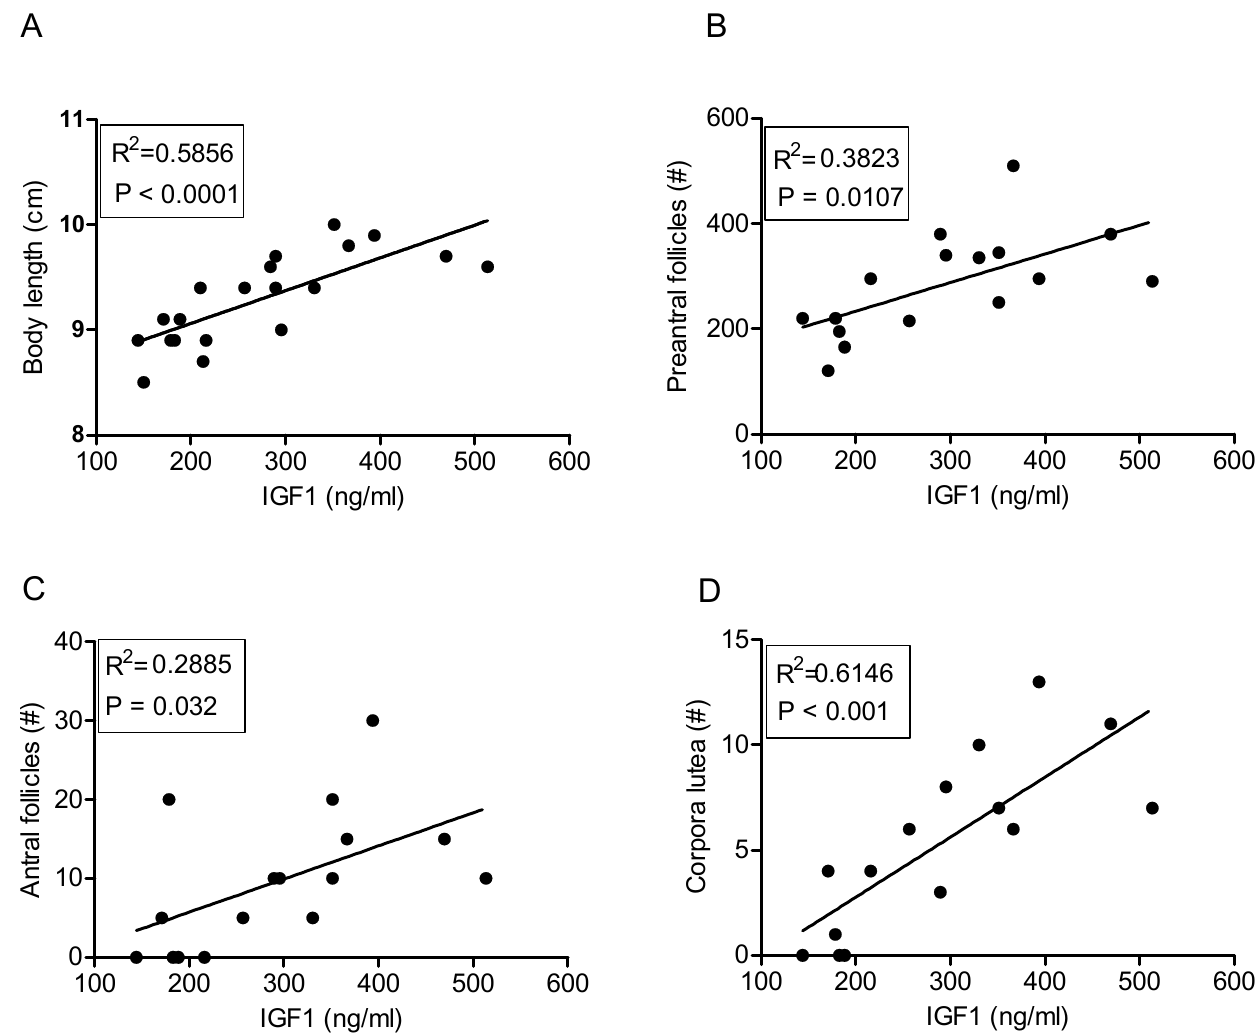
Figure 6. Correlation of plasma IGF1 concentrations with body length and parameters of ovarian follicular development in WT and UCP1-TG (UCP1) mice. Correlations of IGF1 with body length ( A ), number of preantral follicles ( B ), number of antral follicles ( C ) and number of corpora lutea ( D ); n = 8–10.